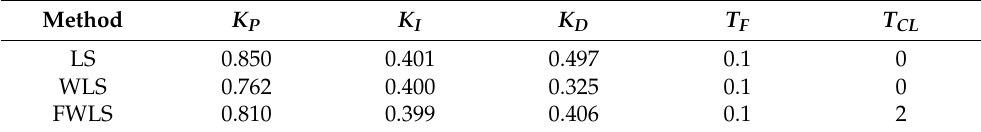
Table 1. The calculated PID controller parameters when using the LS, WLS and FWLS methods.